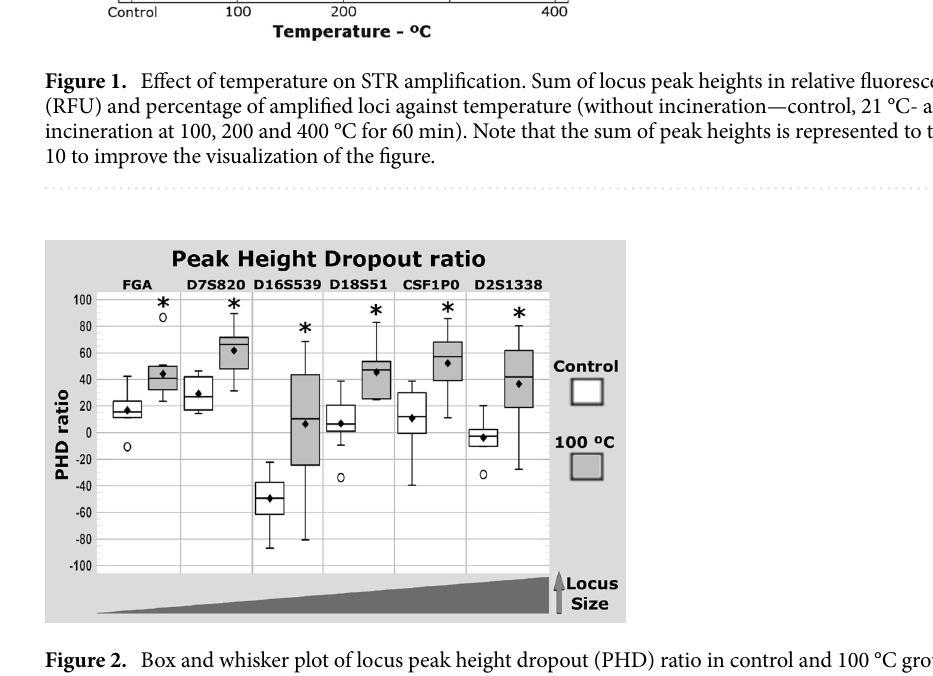
44.06%, 61.80%, 6.33%, 45.36%, 52.22%, and 36.60%, respectively (Tables S2–S7). Locus peak height dropout ratios significantly differed between the control group and the 100 °C group (sum of squared deviations = 3739, 5330, 15,546, 7454, 8595, and 8147 for FGA, D7S820, D16S539, D18S51, CSF1P0, D2S1338, respectively; 1 degree of freedom; p < 0.01) (Fig. 2). Locus peak height dropout ratio, inter-locus balance, and degradation slope (regression model) analysis were carried out between control samples and those exposed to 100 °C, as a low number of loci were amplified from samples exposed to 200 and 400 °C. In fact, 3 and 12 loci were detected in two samples of the 200 °C group, and 7 loci in one sample of the 400 °C group (Table S2). Inter‑locus balance by locus and dye color. Inter-locus balance values close to zero indicate a well-balanced profile, while negative and positive values indicate that the locus has peak heights below or above the mean, respectively (Fig. S7). Figure 3 shows inter-locus balance values for the control and 100 °C groups by dye group. Greater general dispersion of inter-locus values was observed in the 100 °C group than in controls. In the control group, significant differences were found between FAM and NED groups and between the VIC group and the remaining dye groups (p < 0.01). In the 100 °C group, significant differences were found between all dye groups (p < 0.01 or p < 0.05), except between NED and PET. Degradation slope. Figure 4 plots the Oa/Ea ratio for each locus against the molecular weight in base pairs for the control and 100 °C groups. The “Y-logarithmic X-square root” gave the best R 2 value (0.7881). The equation derived from the simple regression model is shown. Intermediate-small molecular weight locus (D5S818, vWA and TH01) had Oa/Ea ratios close to 1. The highest Oa/Ea ratio was for the amelogenin locus (1.23) (Fig. 4).